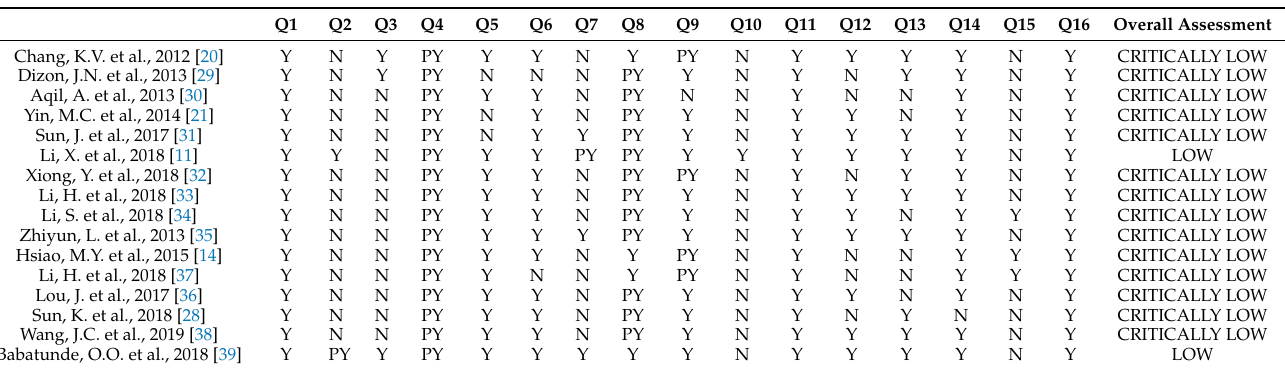
Table 2. Methodological quality of included